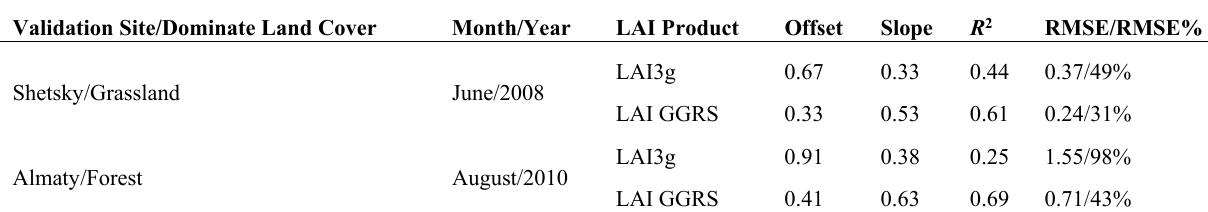
Figure 4. Frequency distributions ( a , b ) and empirical cumulative distribution functions ( c , d ) of Landsat-based LAI, LAI GGRS and LAI3g products at the Shetsky and Almaty validation sites. Table 4. Validation results of LAI3g and LAI GGRS datasets versus the ground-based LAI up-scaled using Landsat imagery.